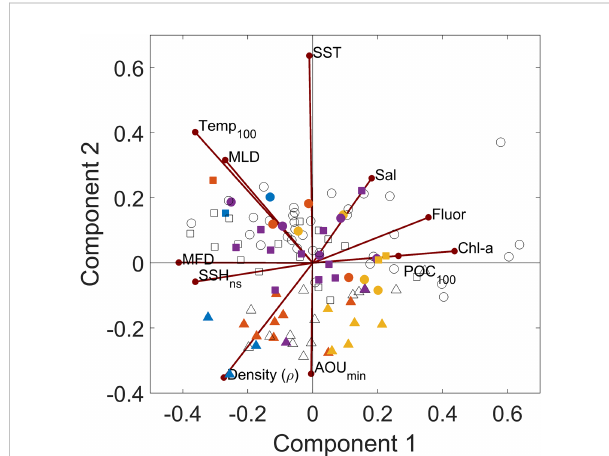
FIGURE 8 Principal component analysis of oceanographic variables and integrated POC 100 estimates. The color indicates the classi fi cation of the mesoscale structures; stations near the center of cyclonic eddies are in yellow, near the border of cyclonic eddies in purple, near the center of anticyclonic eddies in blue, and near the border of anticyclonic eddies in orange. Colorless symbols indicate stations outside of eddies. The stations sampled in 2015 are indicated in circles, 2016 in triangles and 2017 in